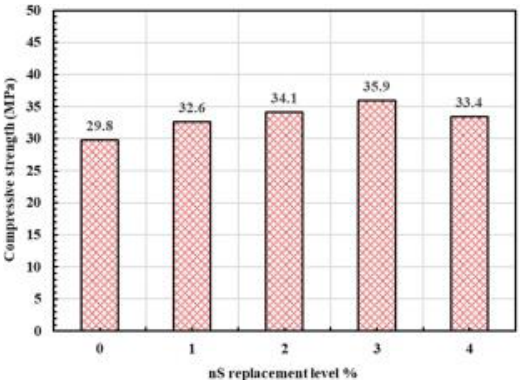
Figure 9. Compressive strength of different NS content at 28 days [76].